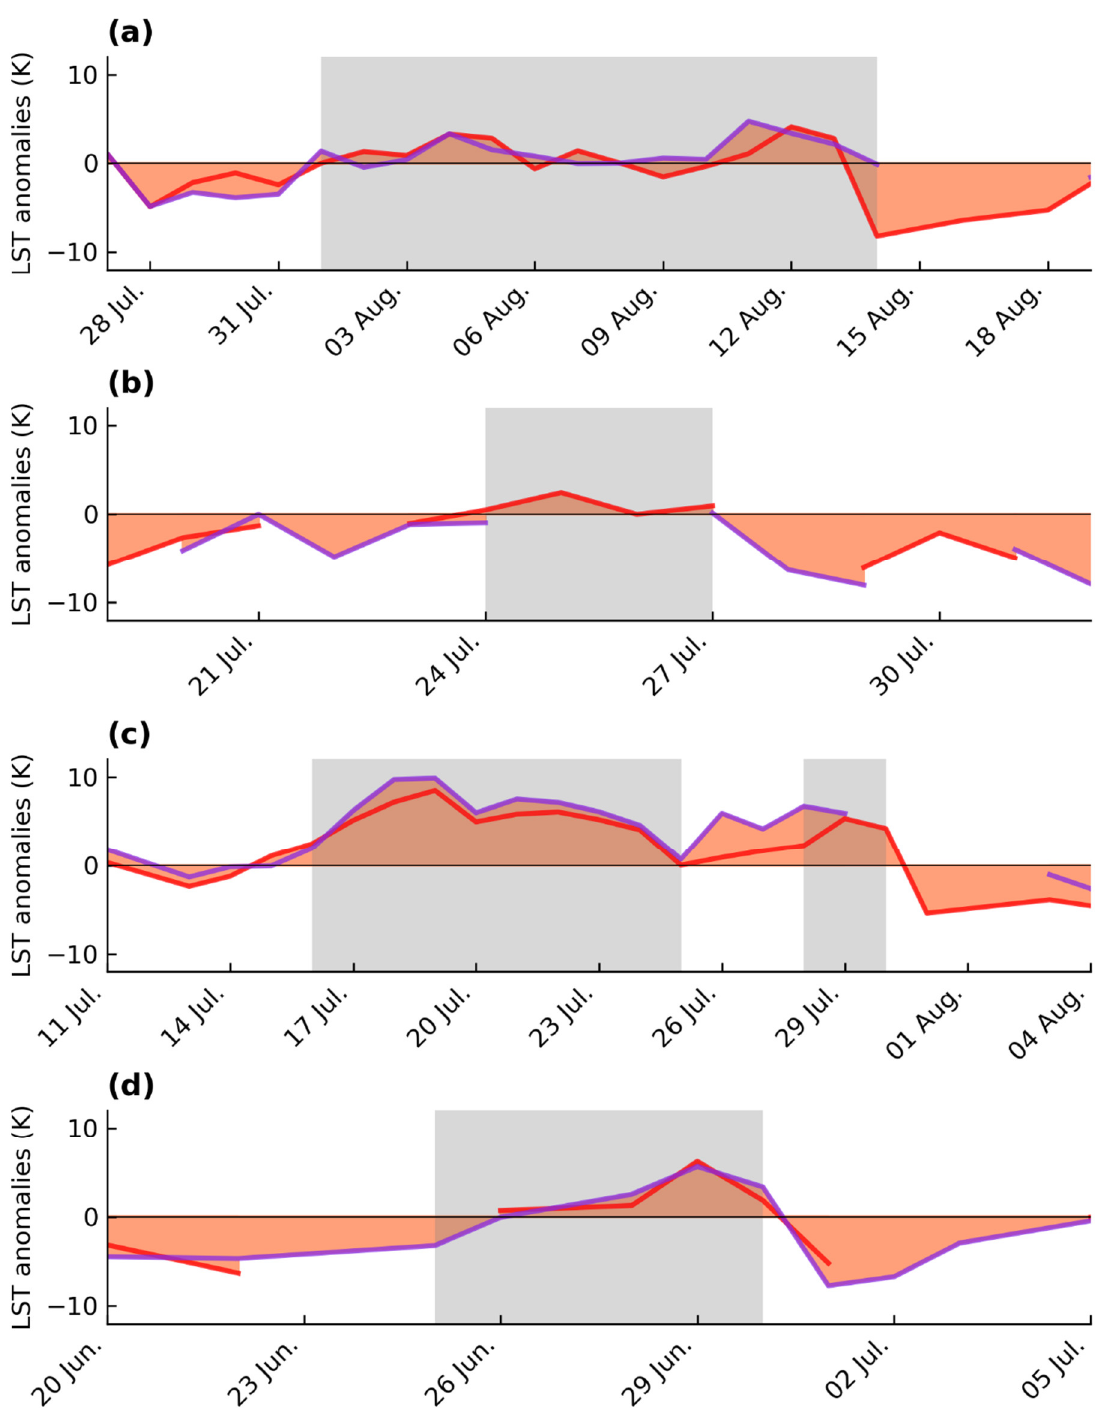
Figure 11. LST anomalies during selected heatwaves in the Mediterranean. ( a ) the 2003 heatwave in Central Europe (FRE00104112; Embrun, France), ( b ) the 2006 heatwave in France (FRE00104907; Montélimar, France), ( c ) the 2007 heatwave in the Balkans (ROE00108893; Craiova, Romania), and ( d ) the 2019 heatwave in Central Europe (SPE00120350; Pamplona, Spain). Shaded areas indicate the dates under a heatwave episode (CTX90pct). The red line corresponds to Terra/MODIS and the purple line to Aqua/MODIS.